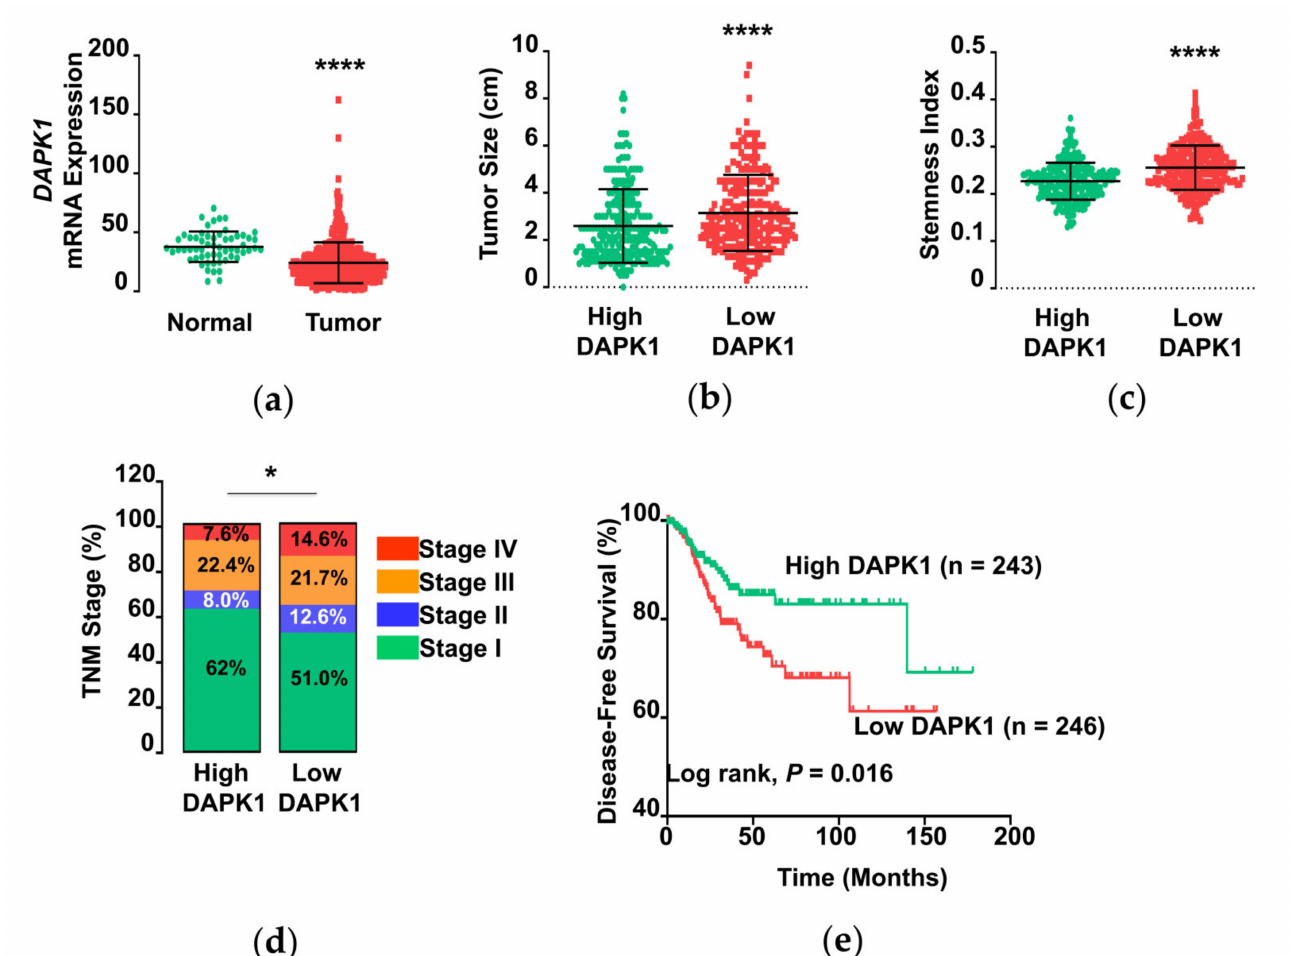
Figure 1. Low DAPK1 expression is associated with poor clinical outcomes in human thyroid cancer. ( a ) Comparison of mRNA expression (TPM, transcripts per million) of DAPK1 between normal thyroid ( n = 59) and tumor tissue ( n = 505). ( b – e ) Comparison of tumor size ( b ), stemness index ( c ), TNM stage ( d ), and disease-free survival ( e ) between high and low DAPK1 tumor group. Transcriptome and clinicopathologic data from TCGA-THCA were analyzed. The disease-free survival was obtained using the Kaplan–Meier estimator. Data represent the mean ± SD. Asterisks ( p < 0.05 (*) and p < 0.0001 (****)) indicate significant differences in the statistical analyses. Abbreviations: TCGA, the cancer genome atlas; THCA, thyroid